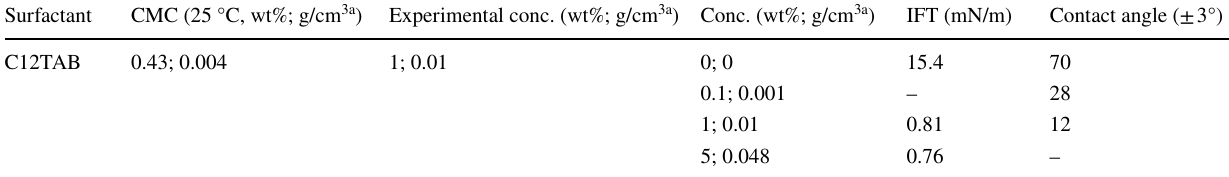
Table 4 Properties of the cationic surfactant C12TAB (Standnes and Austad 2000)